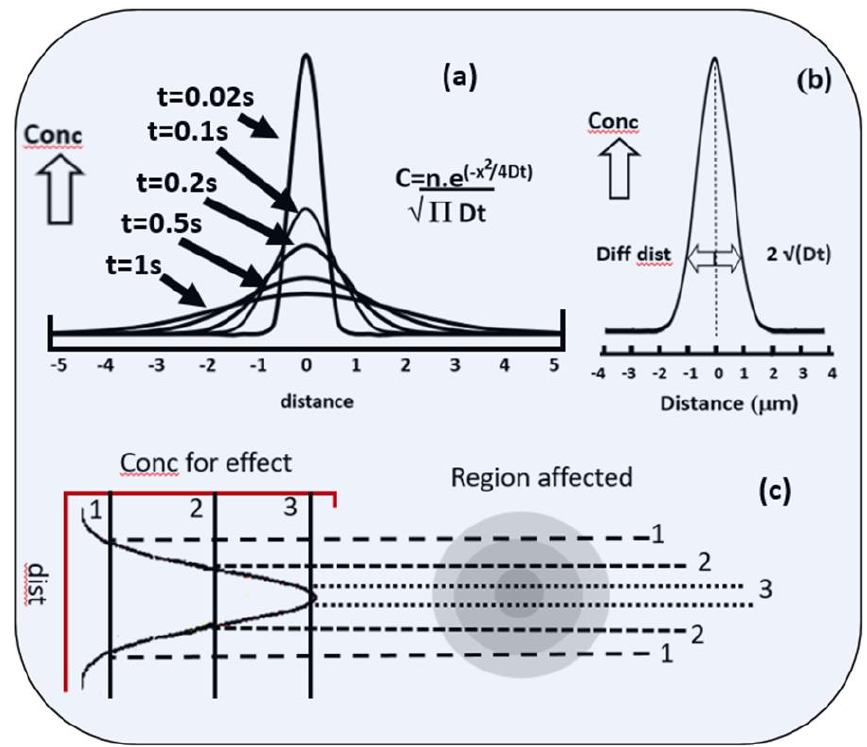
Figure 1. The effect of diffusion of the spread of chemical signals. ( a ) shows the 1-dimenional distribution of the concentration of molecules (or ions such as Ca 2+ ) from a point source (at zero distance) with time using the equation shown, where C=1-dimensional concentration (e.g., molecules or ions/ µ m); n=the number of molecules initially at the source (i.e., at time zero and distance zero): x= distance from the initial source ( µ m); and D=diffusion constant for the molecule (taken here as 1 µ m 2 /s). The concentration of the molecules or ions in the profiles is shown on the vertical axis in arbitrary units. Each curve shows the concentration profile at the time indicated. ( b ) The concentration profile of the signalling molecules at a single time point is shown, with the “diffusion length” (=2 √ (Dt) shown for comparison. ( c ) The effectiveness of the signalling-molecule concentration depends on the target requirement, whether it is activated by a low concentration (shown as 1), medium concentration (shown as 2), or high concentration (shown as 3). The “zone of signalling” is reduced by an increased requirement of the target for the signalling molecule as shown by the 1-dimensional spread of activated target molecules (dotted lines) and a 2- dimensional “target” representation, where the darker shading indicates more signalling effectiveness.